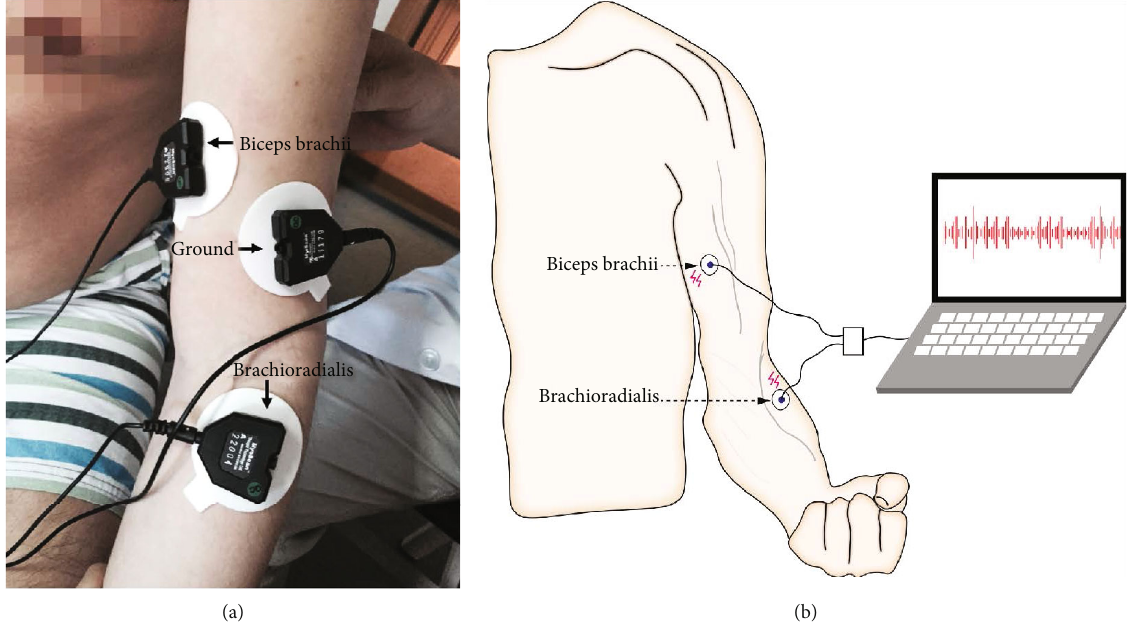
Figure 1: Position of the electrodes on the left upper limb. (a) Electrode locations for the subjects in test. (b) Schematic drawing of electrode